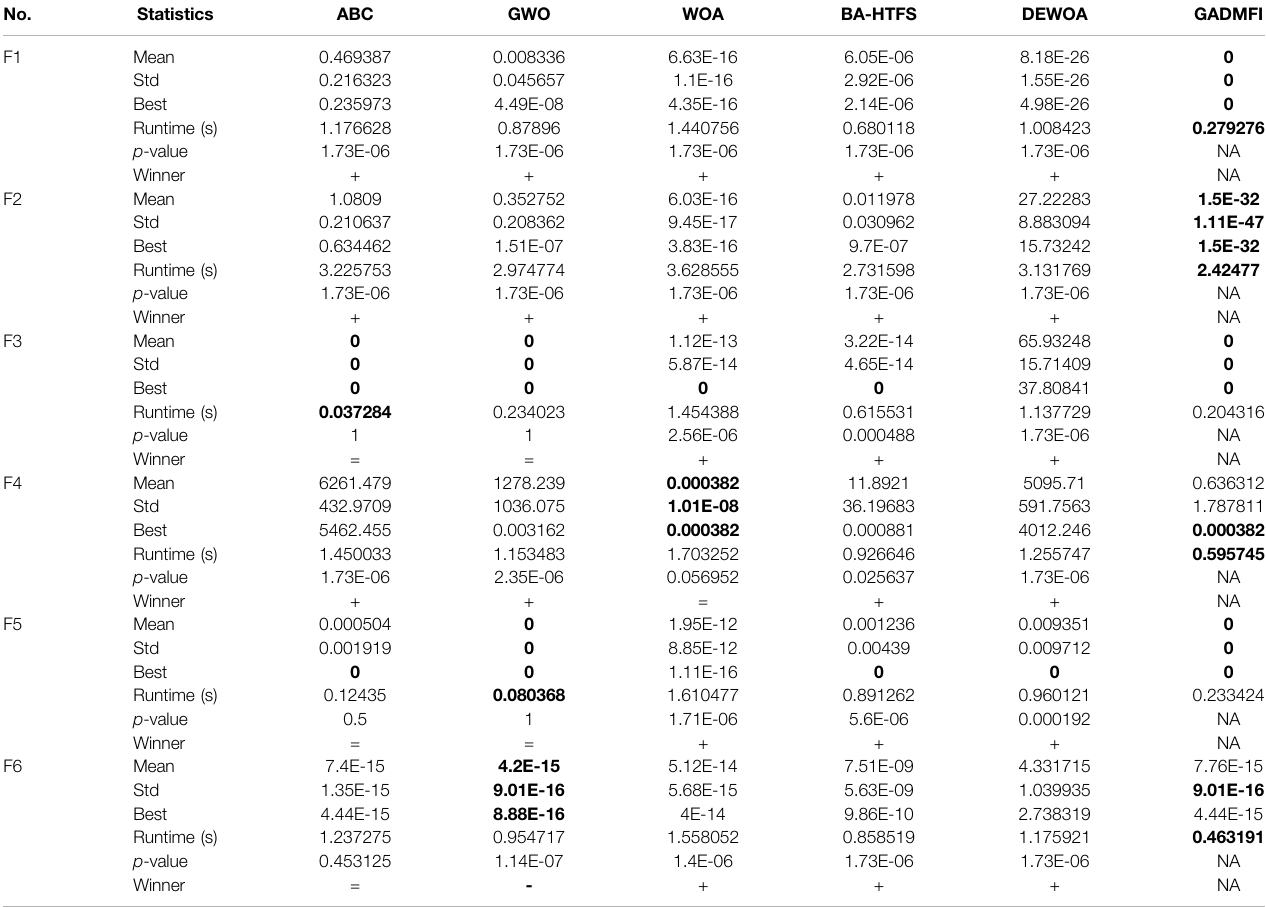
TABLE 5 | The statistics data of 30 runs of the benchmarks of 30 dimensions. No.